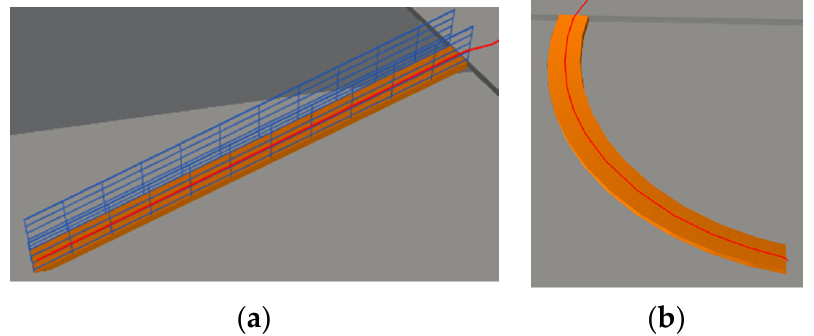
Figure 23. The generation of a 3D topological map of the straight ramp and the curved ramp: ( a ) straight ramp and ( b ) curved ramp.